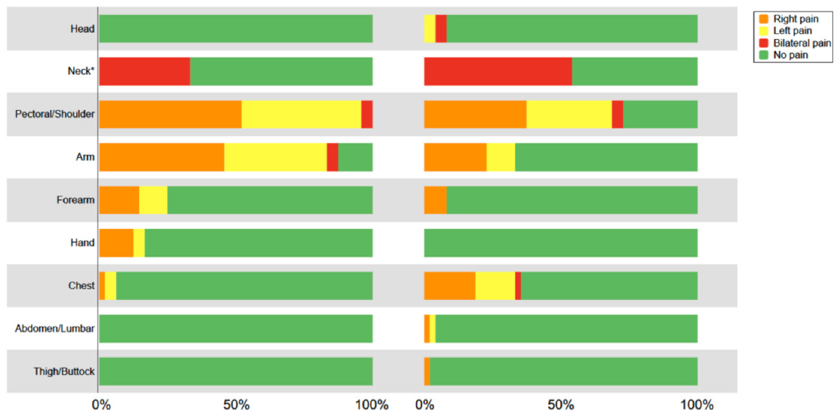
Figure 2. Pain distribution in anatomical regions reported in frontal and dorsal body charts among people with frozen shoulder contracture ( N = 48). * The neck region was not divided into left and right sides.